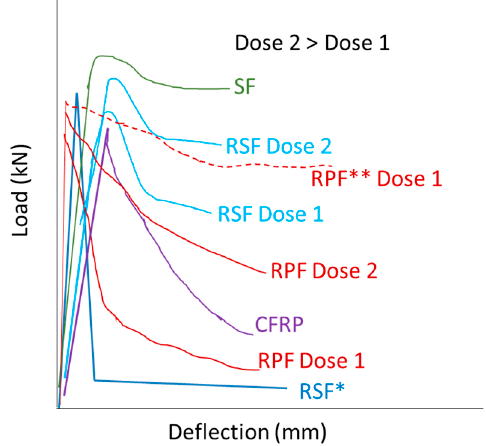
Figure 2. Stress–strain behavior of FRC during bending test. Effect of the dose, nature and origin of the reinforcing fibers. * RSF from machining process discards. ** tension zone confined RPF.